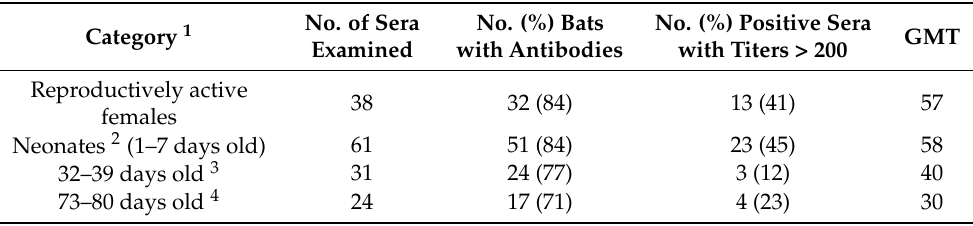
Table 2. Transfer of maternal antibodies: antibody prevalence and titers in different age groups of free-tailed bats, 1973. GMT = geometric mean titer.